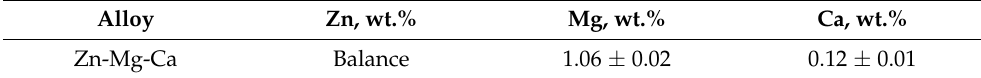
Table 1. The chemical composition of the alloy. Alloy Zn,